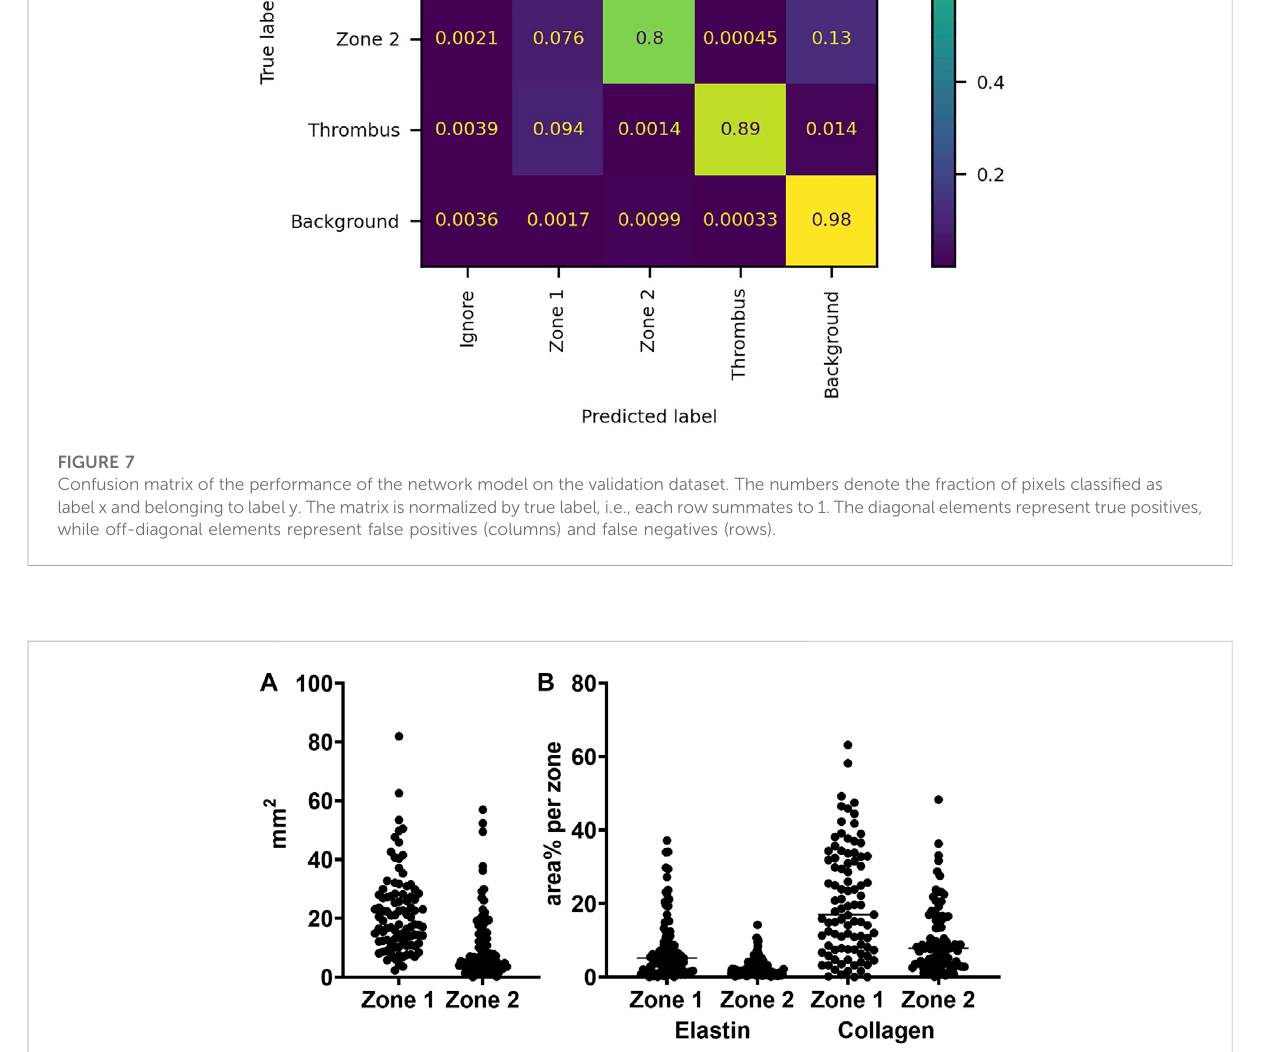
FIGURE 8 Total area and elastin and collagen area percentages in zones 1 and 2. (A) zone area for zone 1 (vascular wall) and zone 2 (perivascular loose connective tissue) (B) area percentages for elastin and collagen in zone 1 and 2,